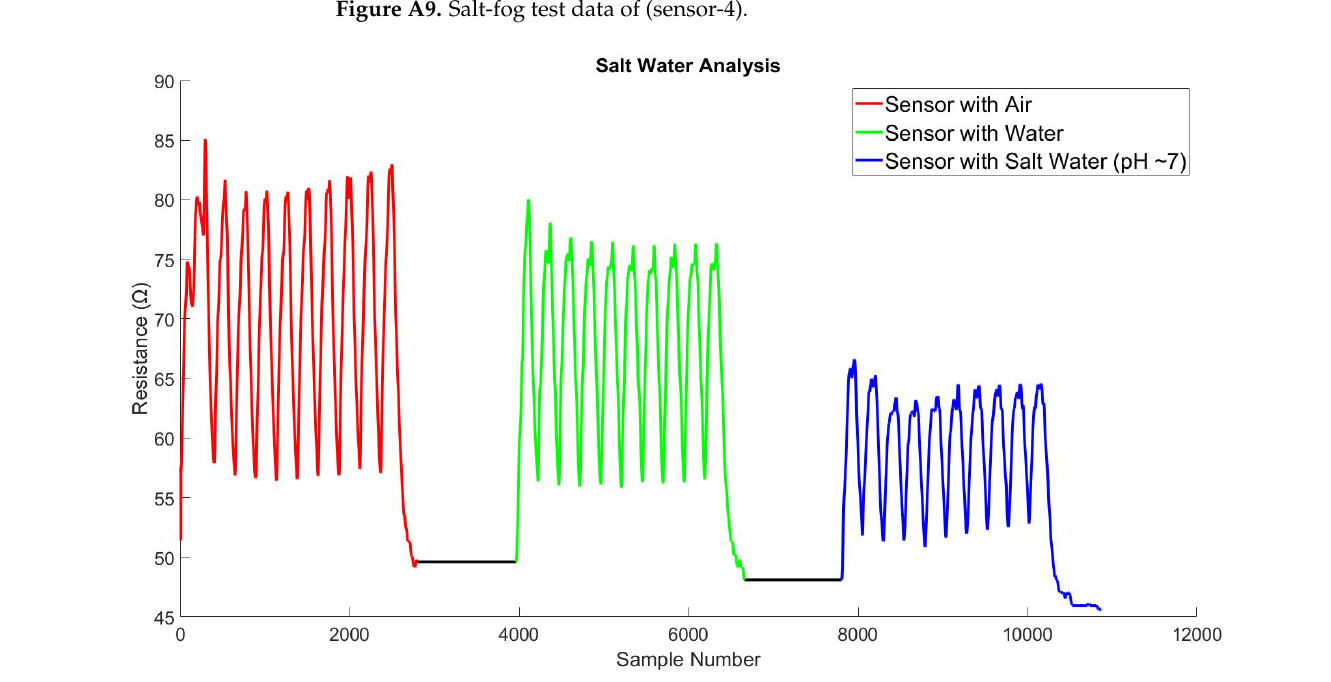
Figure A10. Salt-fog test data of